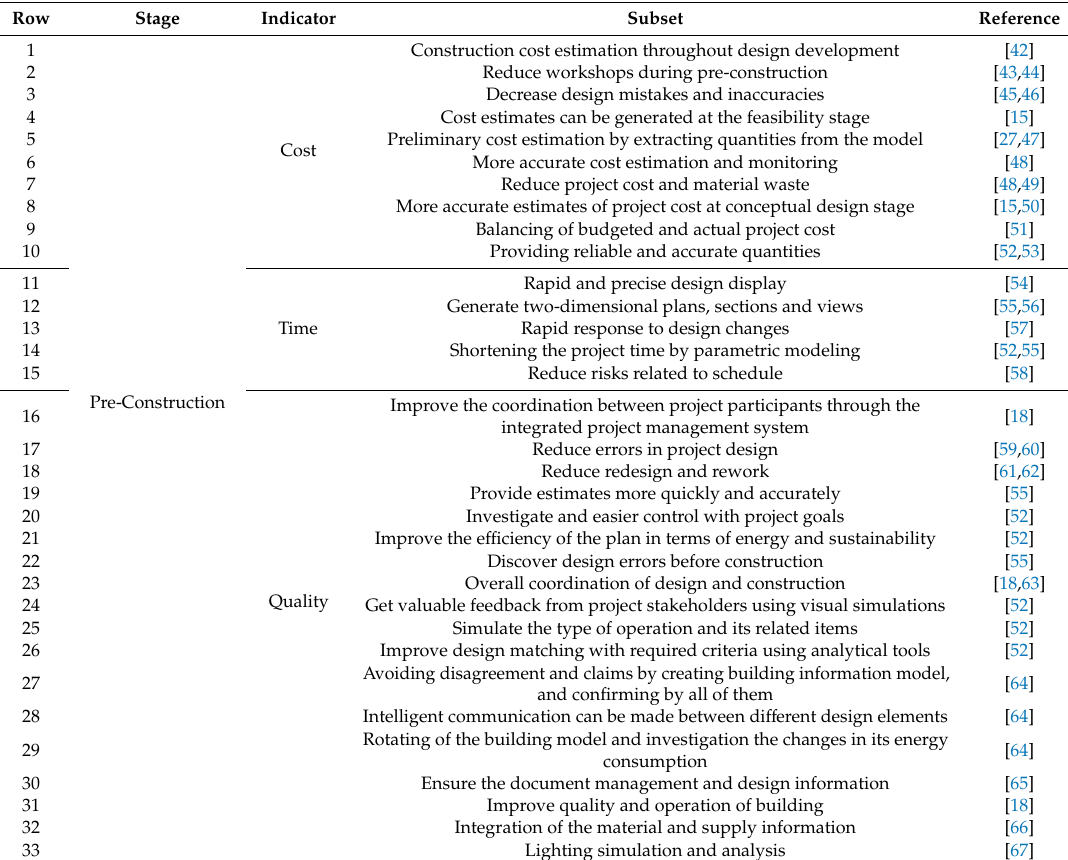
Table A1. Factors a ff ecting the objectives of mass housing projects due to BIM deployment. Row Stage Indicator Subset